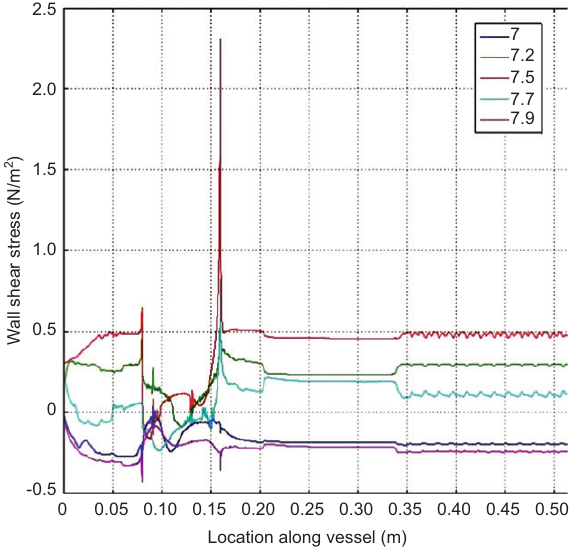
Figure 7 WSS for 55 % aneurysm pulsatile Generalized Power Law model at various time intervals, with 0.13625 m/s max inflow